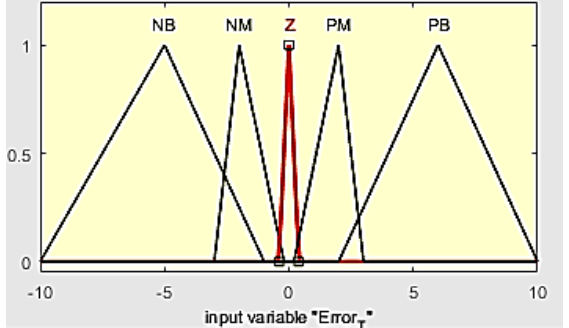
Figure 10. Membership functions of the temperature error.